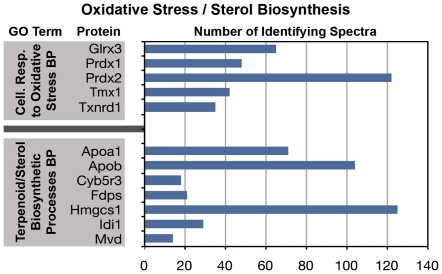
Frequencies of the most abundant spectra identifying proteins under the following GO Terms: “Cellular Response to Oxidative Stress” (BP) and “Terpenoid/Sterol Biosynthetic Processes” (BP).